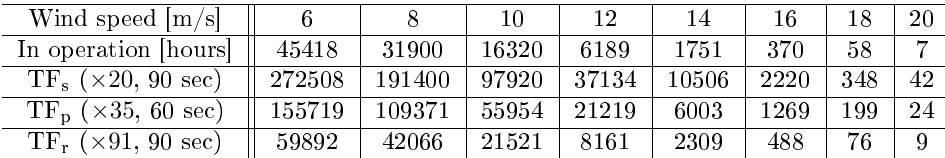
Table 3: Adjusted time scaling for teeth on di(cid:27)erent gears. Last three rows is the fatigue time-factor for a sun, planet or a ring gear tooth. Because the stresses (and gear tooth forces) are comparable, a fatigue calculation does not need to be done on all individual planets.